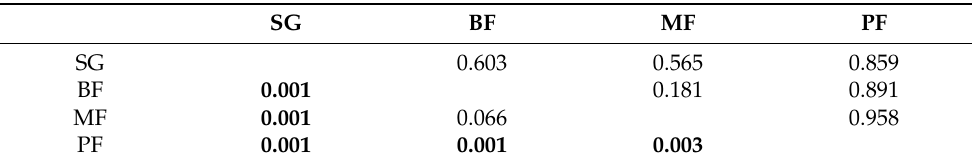
Table 2. Pairwise community dissimilarity test of the soil bacterial communities using analysis of similarity (ANOSIM) based on Bray–Curtis distance.